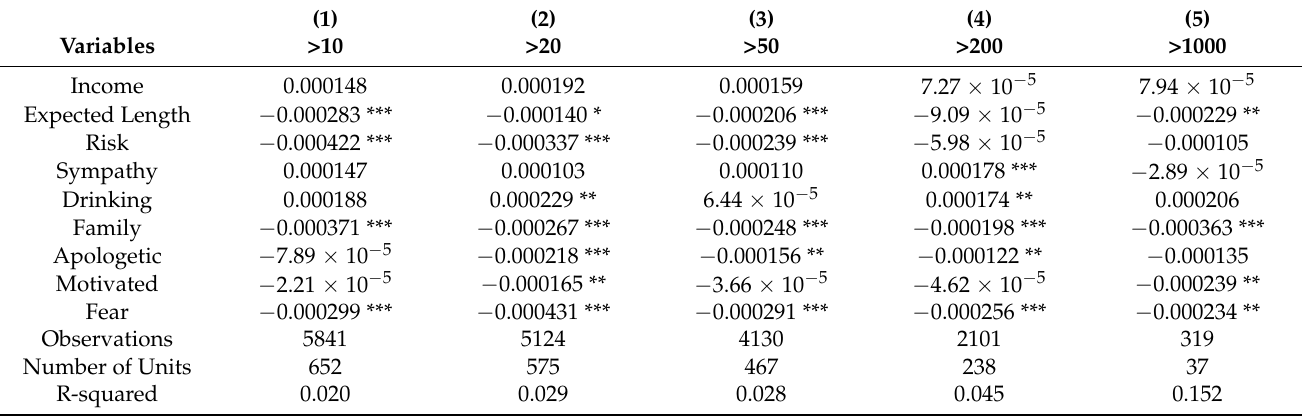
Table 5. Comparison between different sample